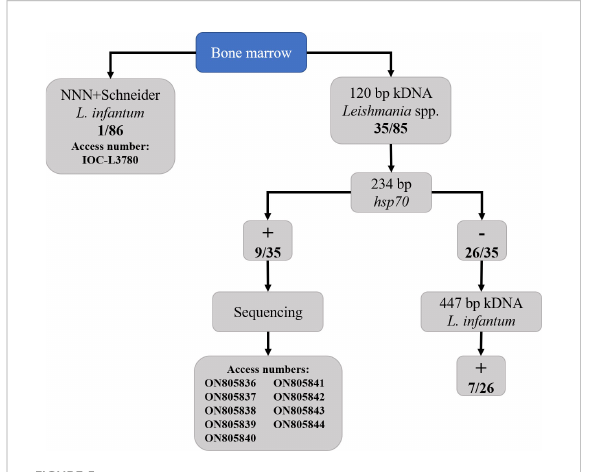
FIGURE 5 Parasitological and molecular detection of Leishmania infantum from the bone marrow samples of South American coatis ( Nasua nasua ) from urban forest fragments in Campo Grande, Mato Grosso do Sul, Midwest